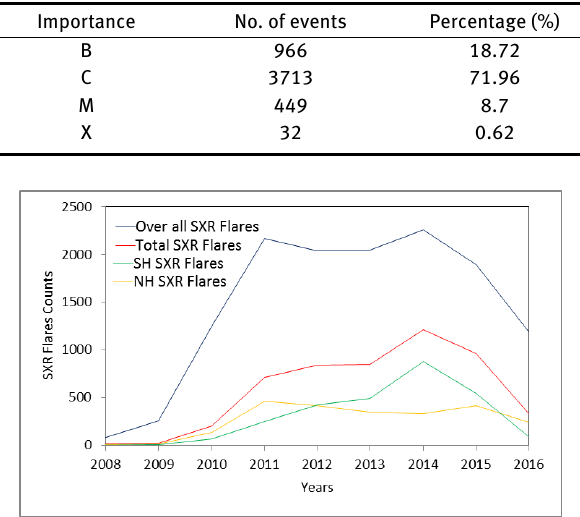
Figure 1. The evolution of the different considered strategies of SXR flares activity during solar cycle 24.